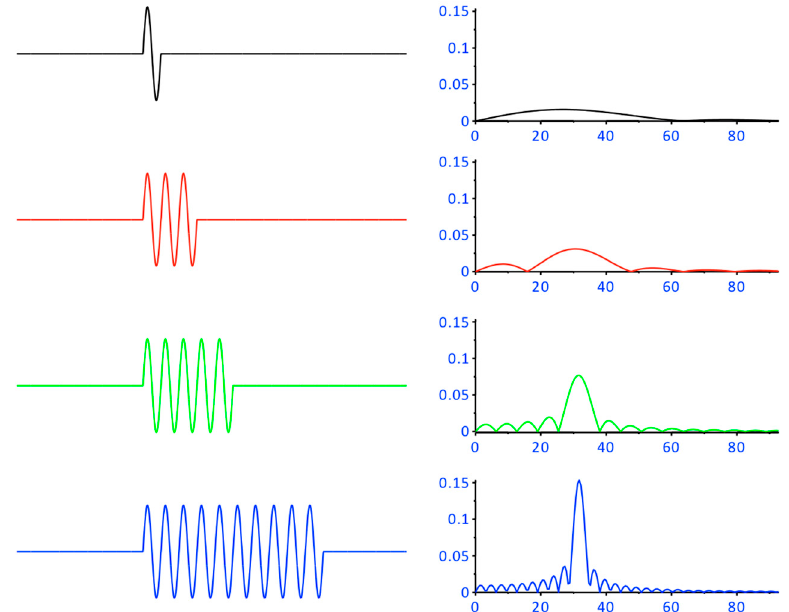
Figure 3. On the left side of the figure, pure sinusoidal oscillations are presented which differ in the number of oscillations but are of the same frequency. The calculated spectra of the sinusoidal oscillations (same frequency!) are shown on the right-hand side (arbitrary units). The upper signal with one full sine wave comes very close to an MEP. The weak representation of this upper signal in the frequency domain on the right is easy to recognize. The better the representation of the signal in the time domain, so does the representation in the frequency domain.